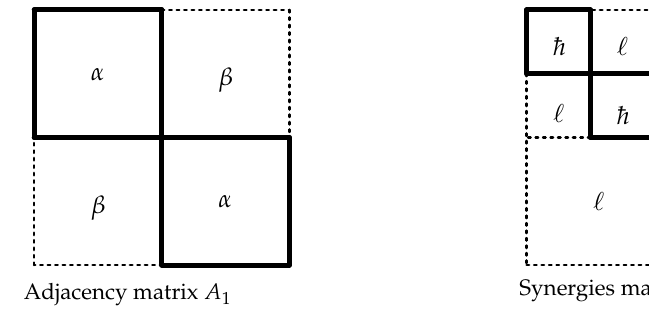
Figure 8. Benchmark graph. Model 1. Table 3. NMI. Model 1.